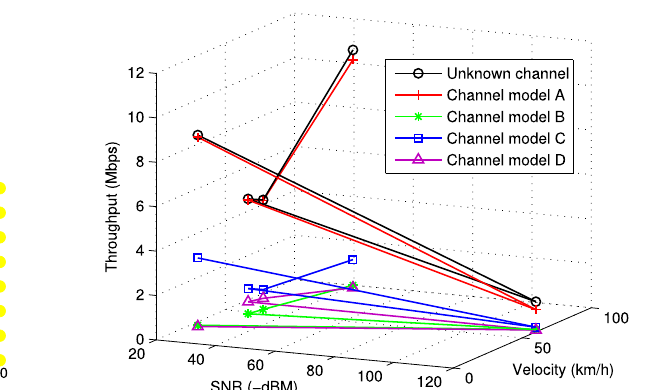
the SNR is 5 dBm and that of the velocity is 15